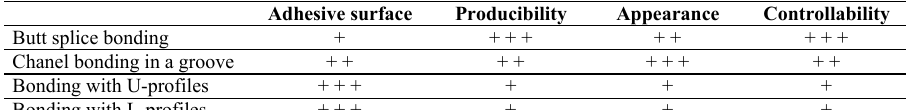
Table 2: Advantages and disadvantages of the different joining details